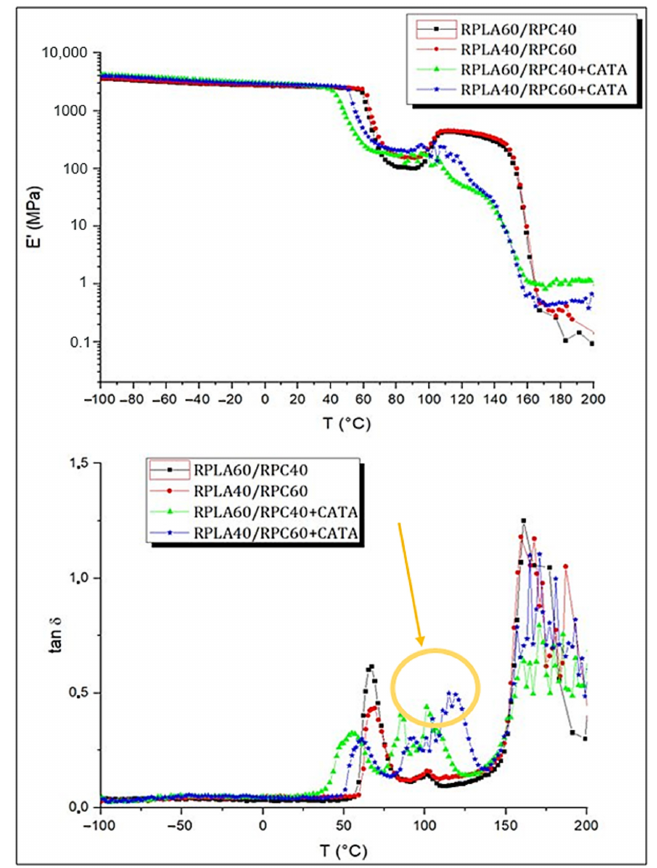
Figure 10. DMTA analysis to evaluate the presence of copolymers.